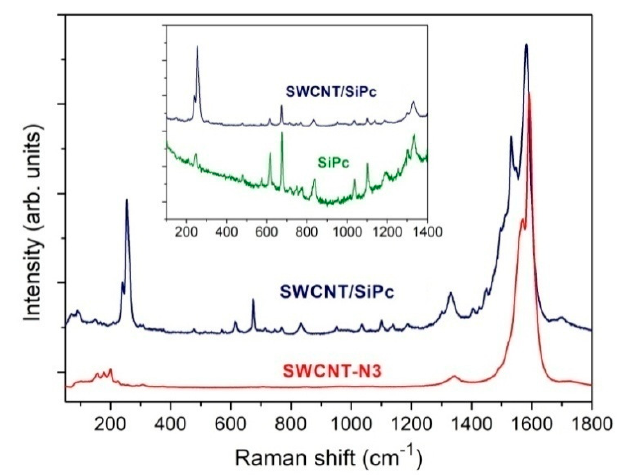
Figure 3. Raman spectrum of SWCNT / SiPc hybrids in comparison with that of SWCNT-N3. The inset shows the enlarged spectrum of SWCNT / SiPc in the range from 150–1400 cm − 1 in comparison with that of SiPc.